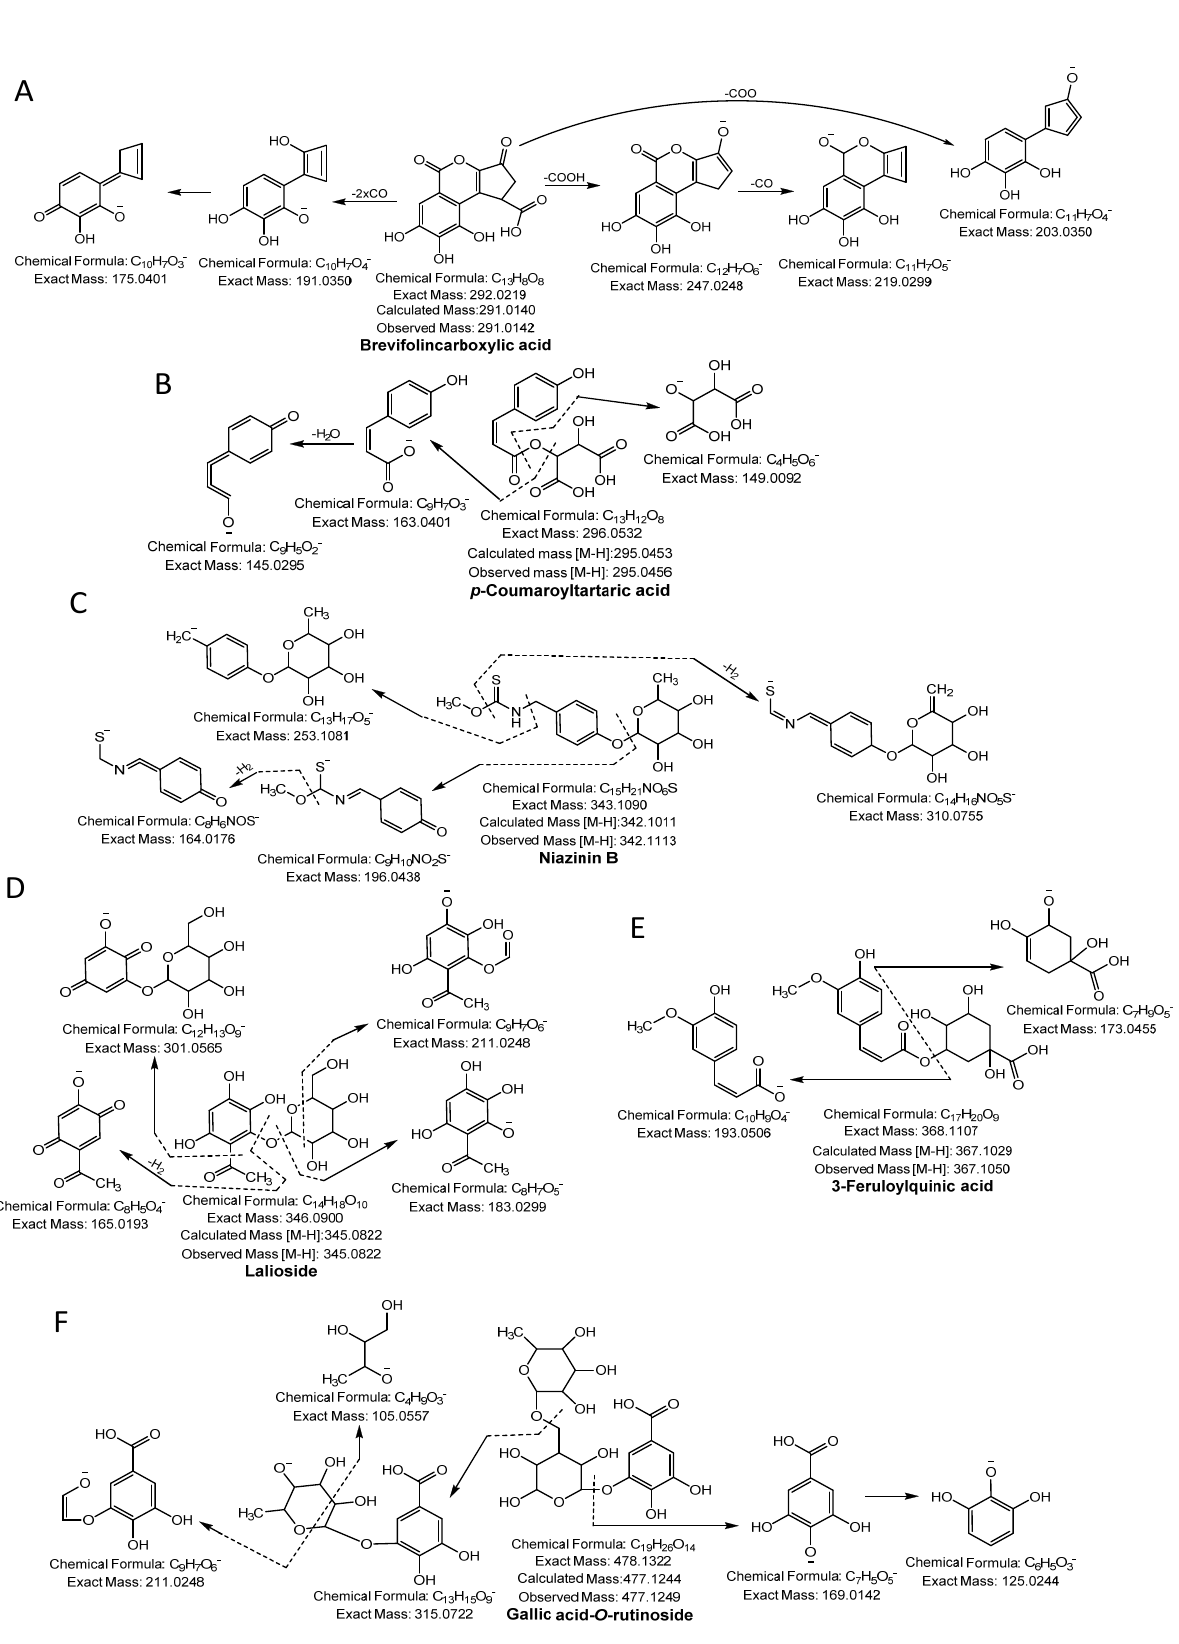
Figure 1. Phenolic acids ( A ) brevifolincarboxylic acid, ( B ) p -coumaroyltartaric acid, ( C ) niazinin B, ( D ) lalioside, ( E ) 3-feruloylquinic acid and ( F ) gallic acid- O -rutinoside were identified in NNSE by ESI-MS/MS.